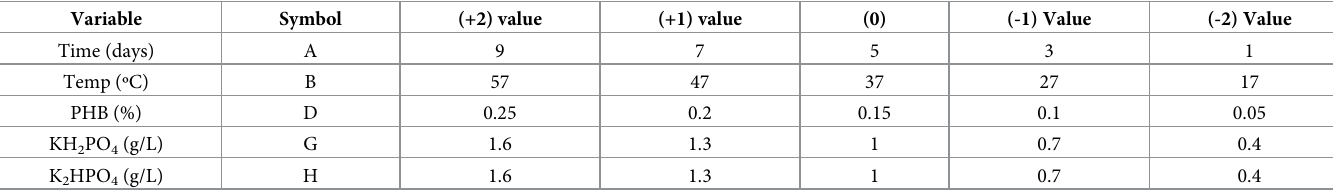
Table 9. Component design of CCD for PHB depolymerase production with the bacterial strain Aeromonas caviae Kuk1-(34) sp. Variable Symbol (+2) value (+1) value (0) (-1) Value (-2) Value Time (days) Temp ( º